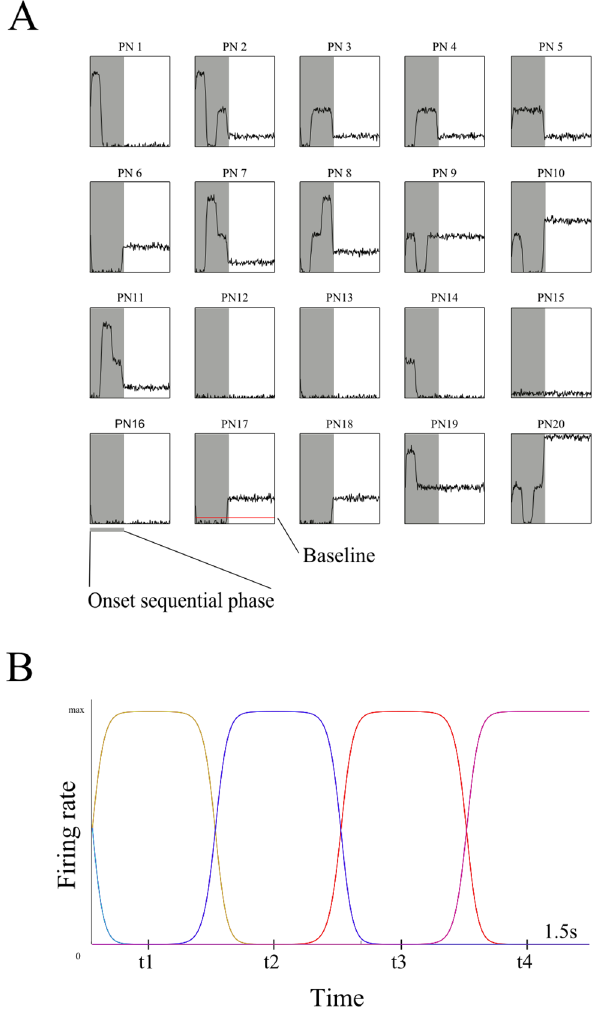
Fig 5. Example activity of the generative model ’ s PN-KC network. Y axis represents instantaneous firing rate, X axis is time. (A) Activity of 20 sample PNs that all connect to the same KC, showing epochs of excitation and inhibition. The shaded area is the onset sequential phase; the rest is the steady state phase. (B): Activity of the KCs during the onset sequential phase where each colored line represents a cluster of three KCs. In total, 15 KCs are shown (five clusters), with maximum firing rates around times t1, t2, t3 and t4. As in Fig 3, the baseline shown is calculated as half the activity level of a PN when only one KC of those connected to it is